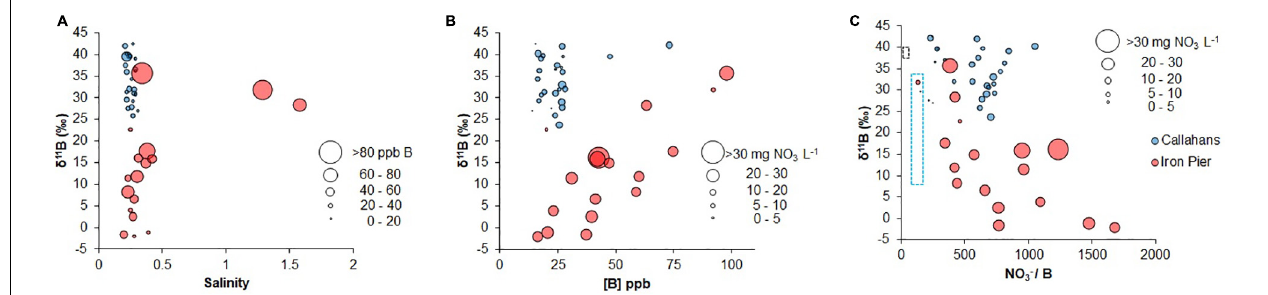
FIGURE 2 | (A) Coastal groundwater salinity vs. δ 11 B with point size reflecting B concentration (A) ; B concentration vs. δ 11 B with point size reflecting NO 3 − concentration (B) and NO 3 /B vs. δ 11 B with point size reflecting NO 3 − concentration (C) . The range of seawater ( ∼ 0.5 mg N L − 1 ) and precipitation ( ∼ 1 mg N L − 1 ) in panel (C) are represented by dashed black and blue rectangles, respectively.